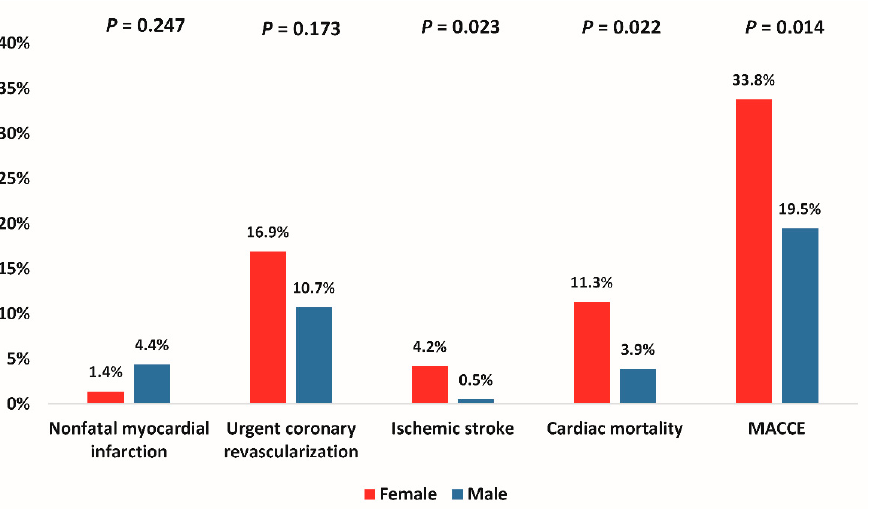
Figure 1. Adverse events during the study period. Legend: MACCE, major adverse cardiovascular and cerebrovascular events (composite of cardiac mortality, ischemic stroke, urgent coronary revascularization and nonfatal myocardial